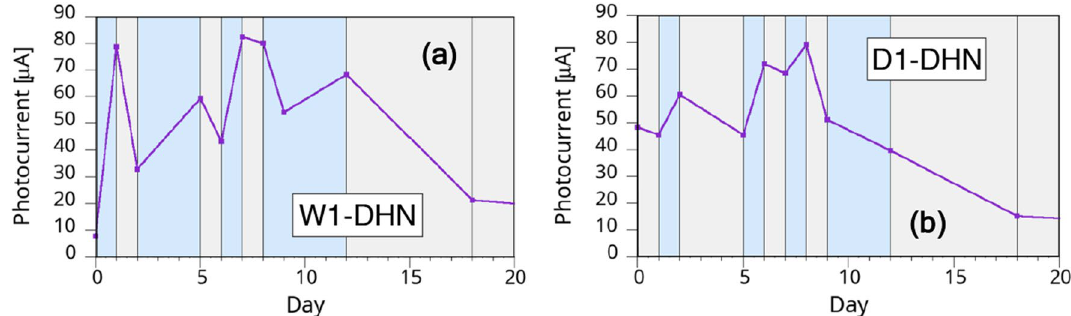
Figure 7. Behavior of PSi samples with DHN-based melanin: ( a ) W1-DHN sample and ( b ) D1-DHN sample. The grey and light blue areas indicate dry and wet storage environment,